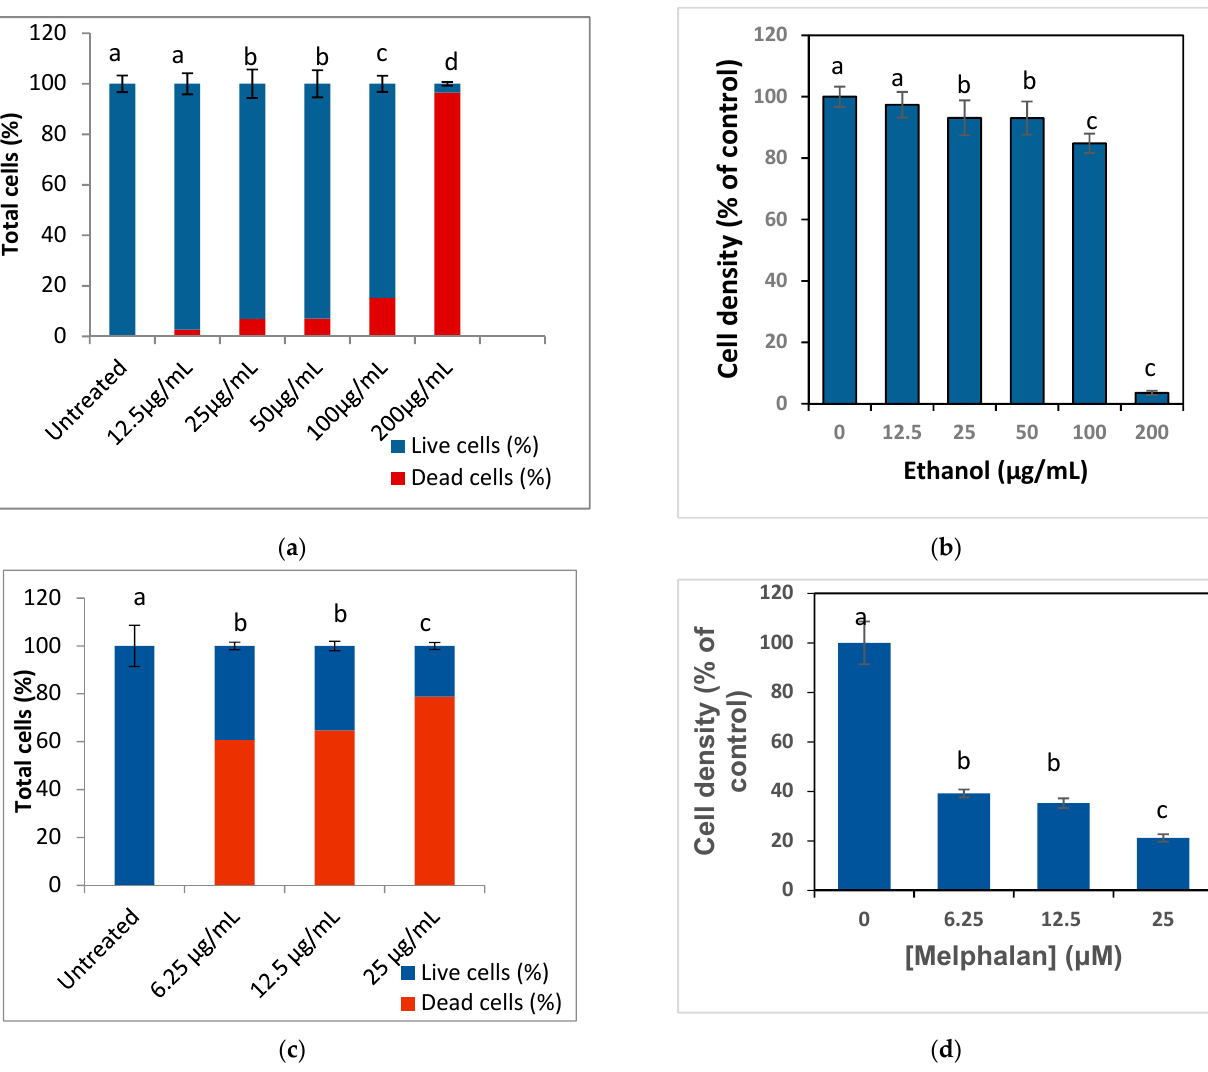
Figure 2. Cytotoxicity screening of ethanol extract of H. arborescens leaves and melphalan (positive control). ( a ). Total number of C3A cells after treatment with ethanol extract. ( b ) Cell density after treatment with ethanol extract. ( c ) Total number of C3A cells after treatment with Melphalan. ( d ) Cell density after treatment with Melphalan. Dead cells were represented as cells with compromised membrane integrity and subsequent propidium iodide (PI) staining and Live cells obtained from Hoechst 33,342 staining. Values are expressed as mean ± SD ( n = 2). Mean separation by SD ( p < 0.05). Set of bars with different alphabets are significantly different.